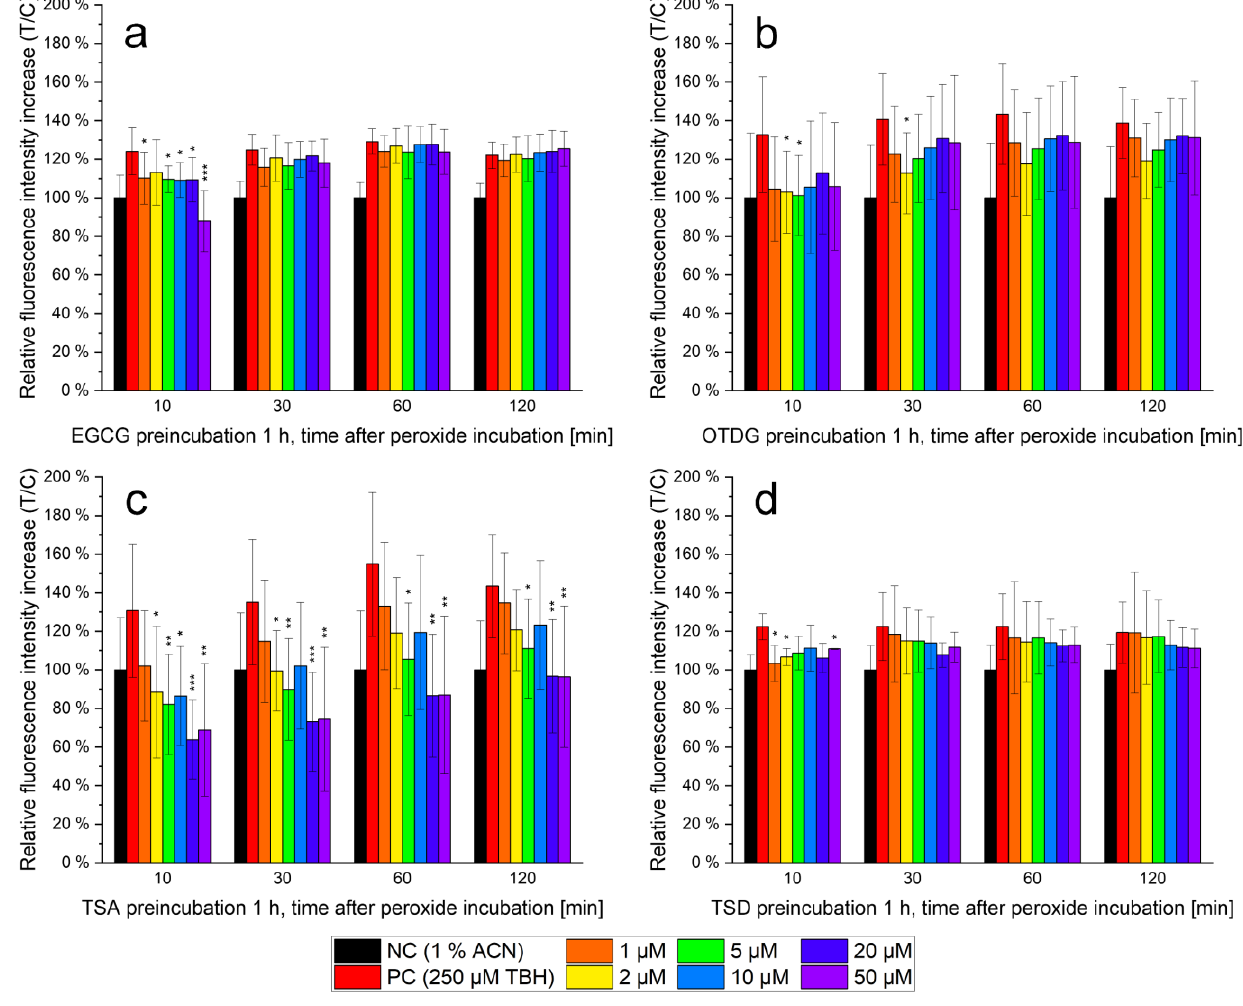
Figure 4. Modified DCFH 2 -DA assay for evaluation of antioxidant properties in vitro; relative fluorescence intensity increases in HepG2 cells after administration of DCFH 2 -DA and—except for the negative control (NC) — 250 µM tert -butyl hydroperoxide (TBH), n = 6, statistical evaluation via Student’s two -way t test against the negative control with P as significance value marked with asterisks (* p = 95%, ** p = 99%, *** p = 99.9%), including a pre-incubation (except NC and positive control (PC)) with ( a ) EGCG, 1 – 50 µM; ( b ) OTDG, 1 – 50 µM; ( c ) TSA, 1 – 50 µM; ( d ) TSD, 1 – 50 µM.